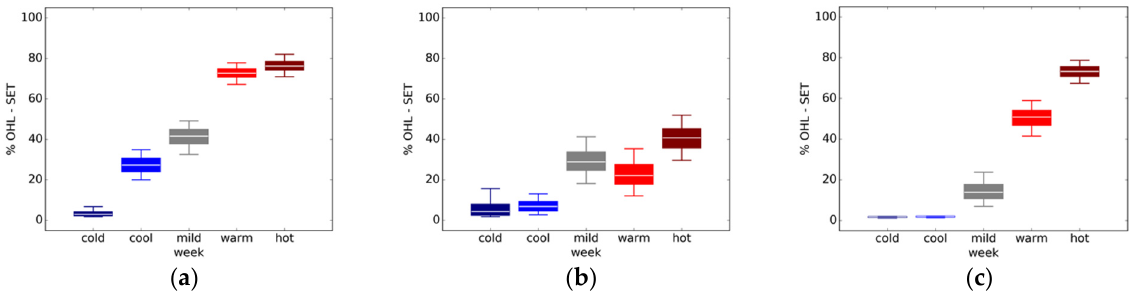
Figure 2. Thermal OHL for Houston ( a ), San Francisco ( b ), Chicago ( c ).